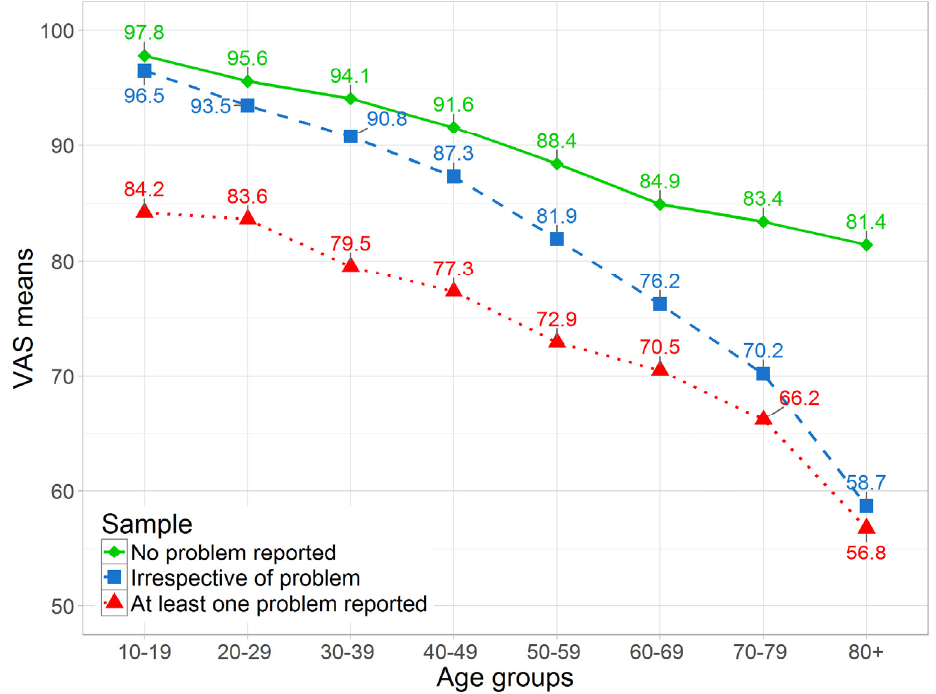
Figure 2. VAS means based on age group, stratified by optimal and non-optimal health state, aggregated sample. No problem reported shows the average VAS score for the subsample of participants with a descriptive score of 11111 ( n = 3739). At least one problem reported refers to the subsample of remaining participants with at least one dimension score >1 ( n = 2335). Irrespective of problem depicts the whole sample ( n = 6074).